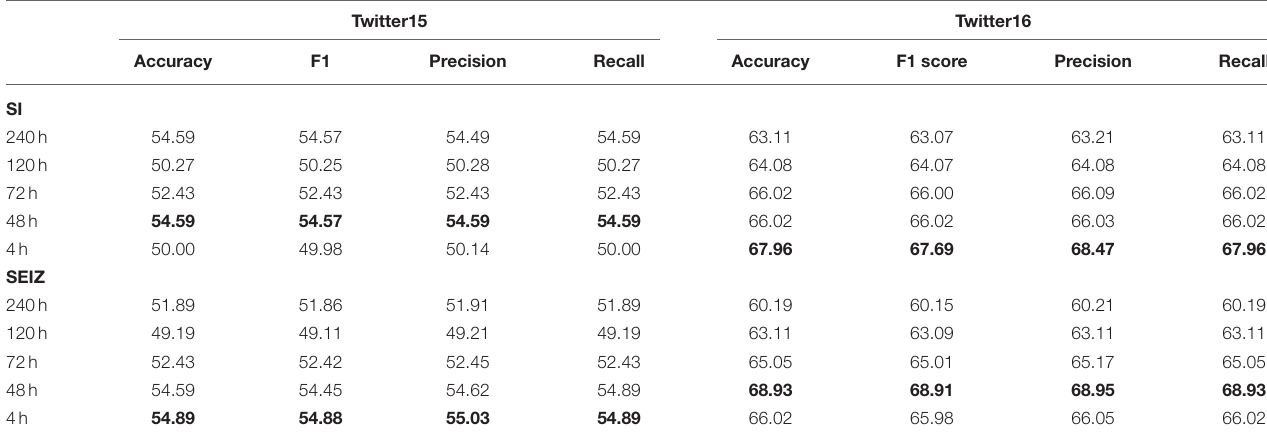
TABLE 4 | Twitter15 and Twitter16 SI and SEIZ binary classification results.